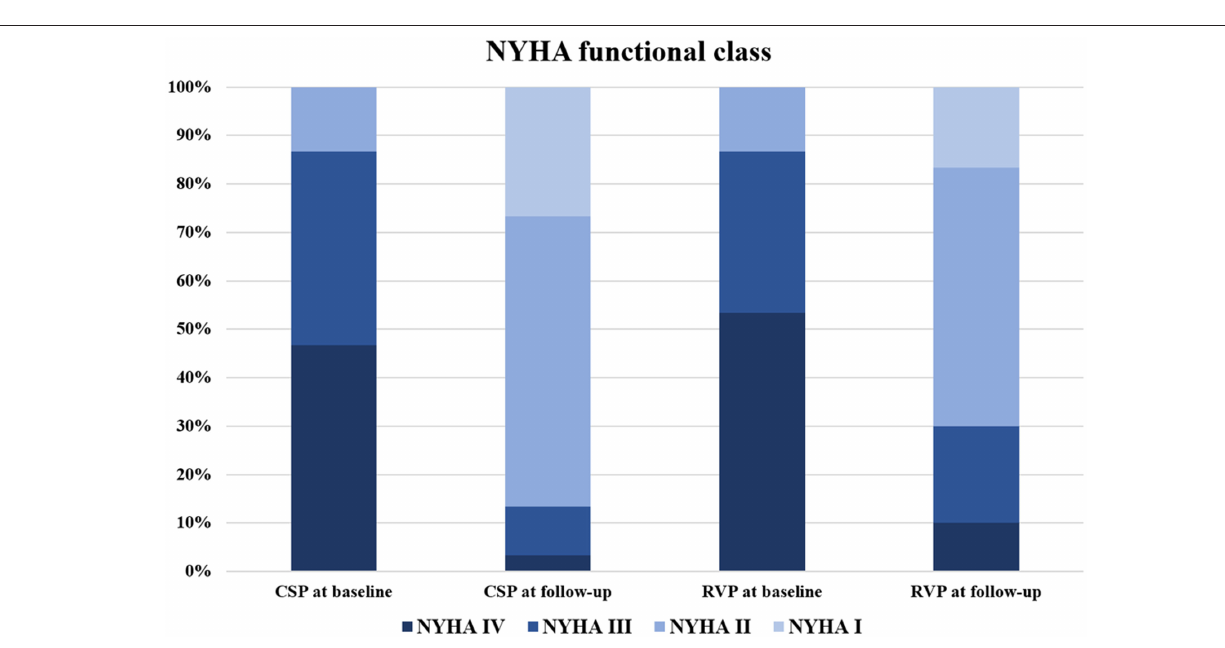
FIGURE 4 | NYHA functional class evaluation between CSP and RVP. CSP at baseline vs. RVP at baseline: p = 0.94; CSP at follow-up vs. RVP at follow-up: p = 0.47; CSP at baseline vs. CSP at follow-up: p < 0.01; RVP at baseline vs. RVP at follow-up: p < 0.01. CSP, conduction system pacing; NYHA, New York Heart Association; RVP, right ventricular